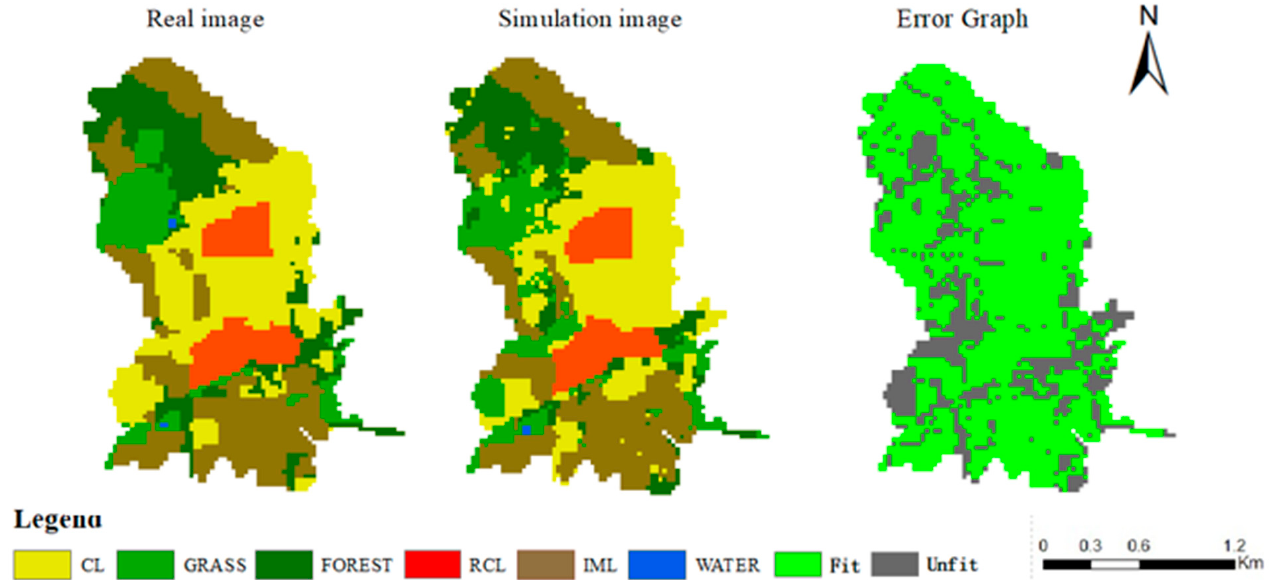
Figure 9. LUCC simulation results in 2019: cultivated land (CL), grassland (GRASS), forestland (FOREST), rural construction land (RCL), industrial and mining area (IML), water (WATER), and the error graph.